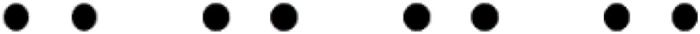
Sequence to illustrate the “factor of proximity” (patterns similar to Wertheimer, 1938, p. 72).